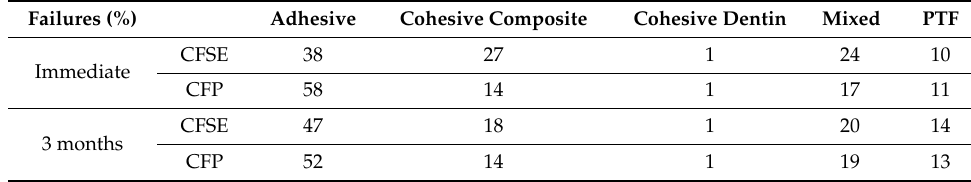
Table 4. Summary of the fractographic analysis showing the different types of failures seen in each experimental group (presented as %). PTF indicates pre-testing failure–beams which fractured before bond strength testing was carried